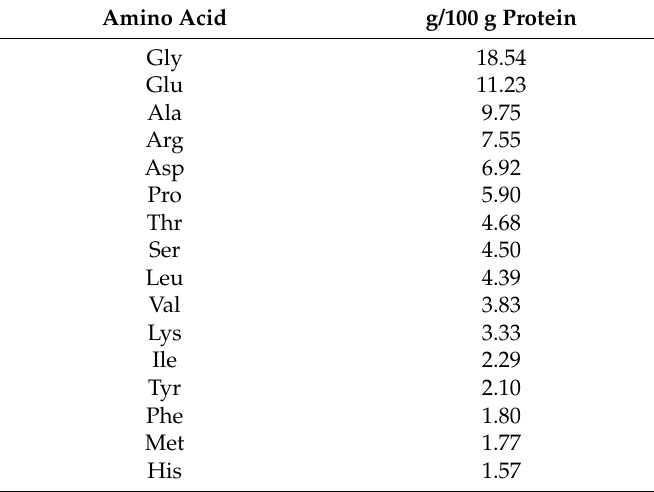
Table 2. Amino acid composition of SCP.